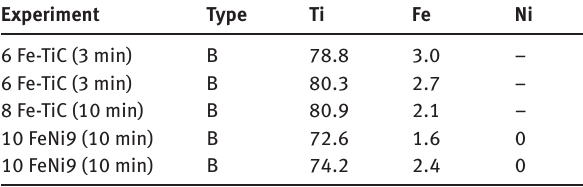
Table IV: Analyses of big TiC particles found in the alloy droplet (balance carbon). (All values in mass%).